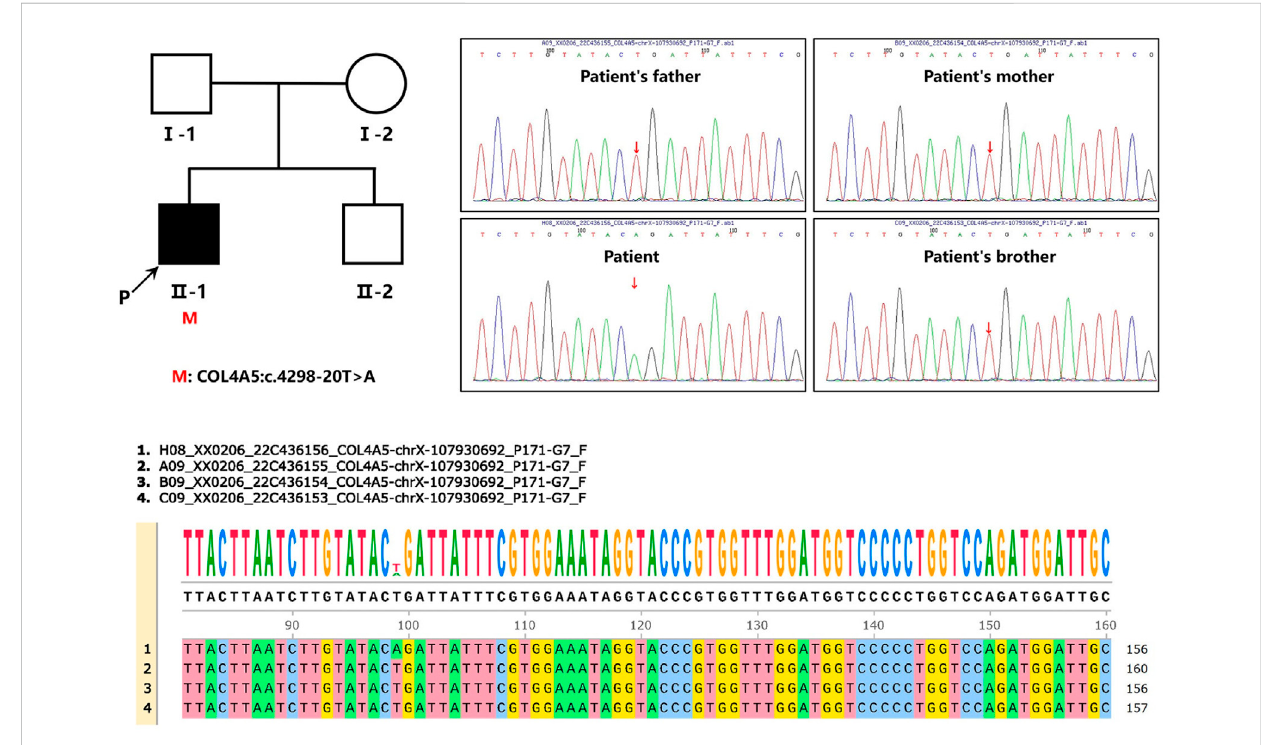
FIGURE 2 PedigreeandsequencingofpatientfromoneunrelatedChinesefamily.Anarrowpointstothepatientinvolvedinthisstudy.Analysisofthegenomic DNA of the designated patient, his parents, and his fi ve-year-old brother by Sanger sequencing. The gene variation is shown by a red